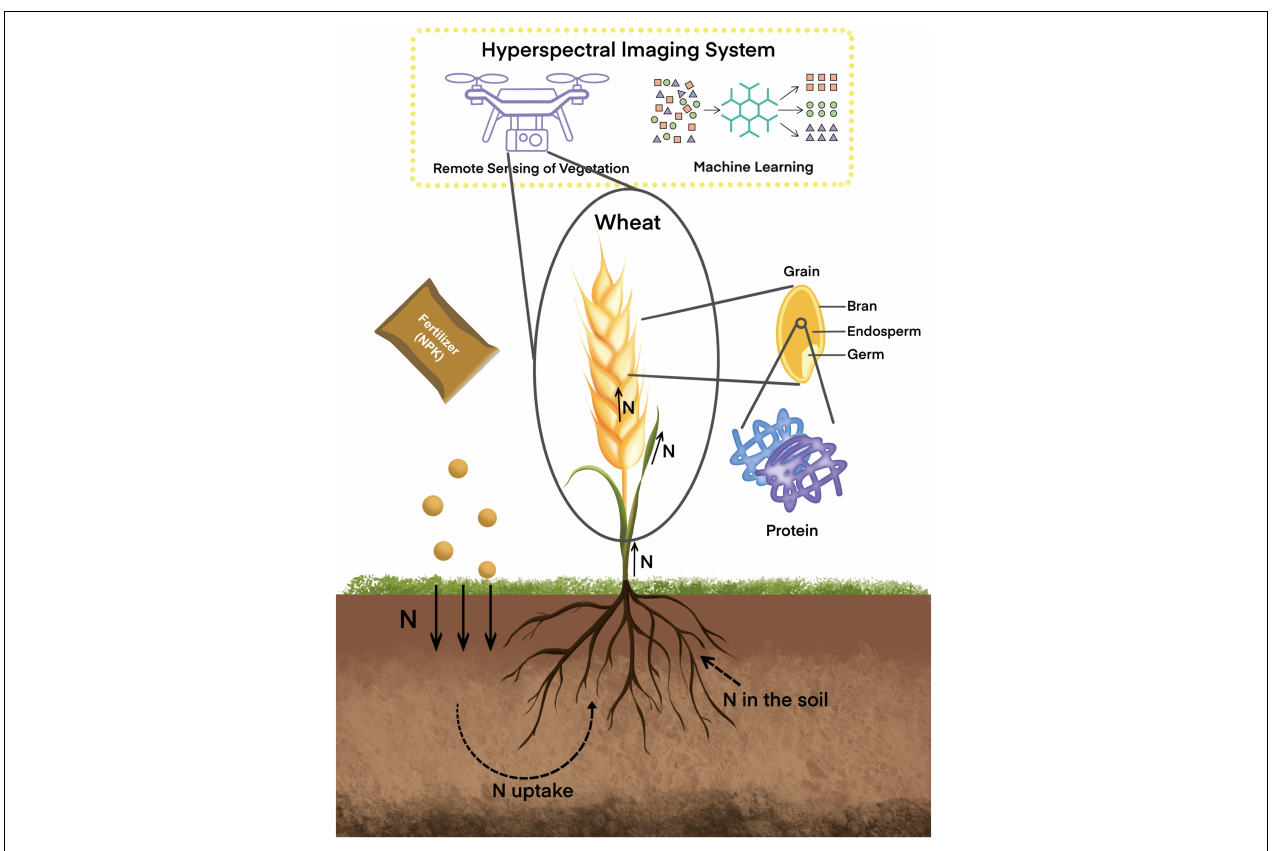
FIGURE 1 | It is a review of hyperspectral imaging systems for evaluating wheat grain protein. Hyperspectral imaging systems, a combination of hyperspectral remote sensing and machine learning, have significant advantages in evaluating wheat grain proteins. Hyperspectral remote sensing can capture information reflecting nitrogen (N) status in wheat plants in real-time and non-destructively. Meanwhile, machine learning can effectively simulate the non-linear relationship between nitrogen and spectral data of wheat. Hyperspectral imaging systems are now widely used to predict wheat grain protein content (GPC), and crop models can complement the analysis of eco-physiological mechanisms in the prediction